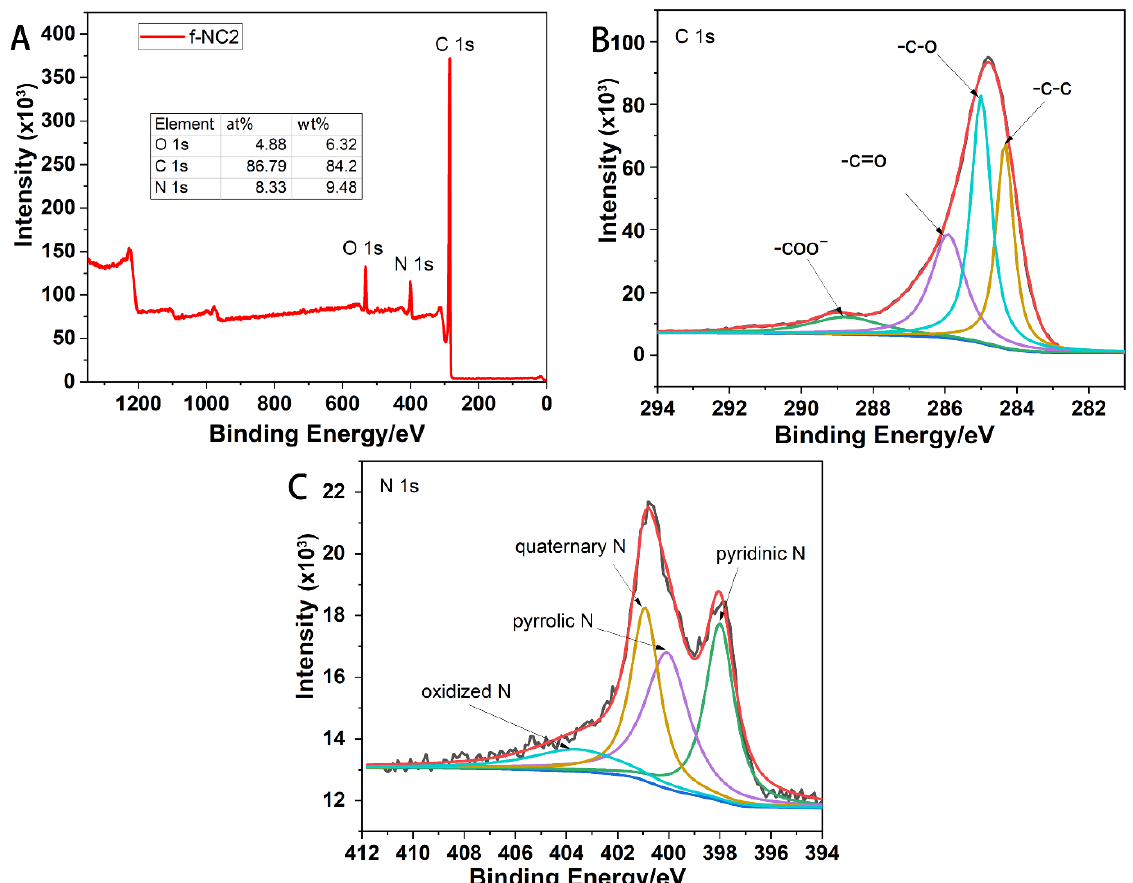
Figure 3. XPS spectra of the f-NC2 nanohybrid: ( A ) survey spectrum, ( B ) C 1s spectrum, ( C ) N 1s spectrum.